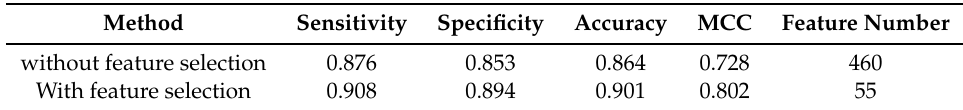
Table 5. Prediction results for Golgi-resident protein types using 3-gap DC+CSP-PSSM-